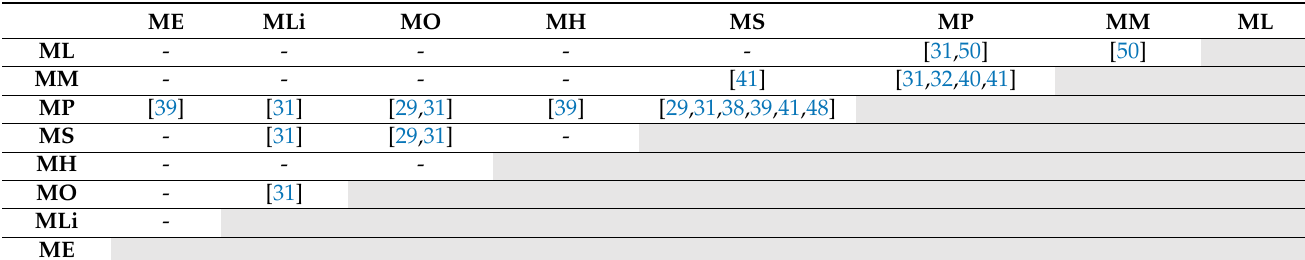
Table 5. References described in Section 2.2, ordered by the two compounds of the mixture 1 .